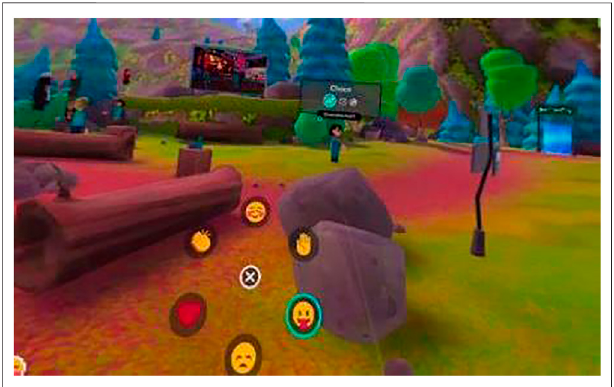
FIGURE 2 | Ray casting in